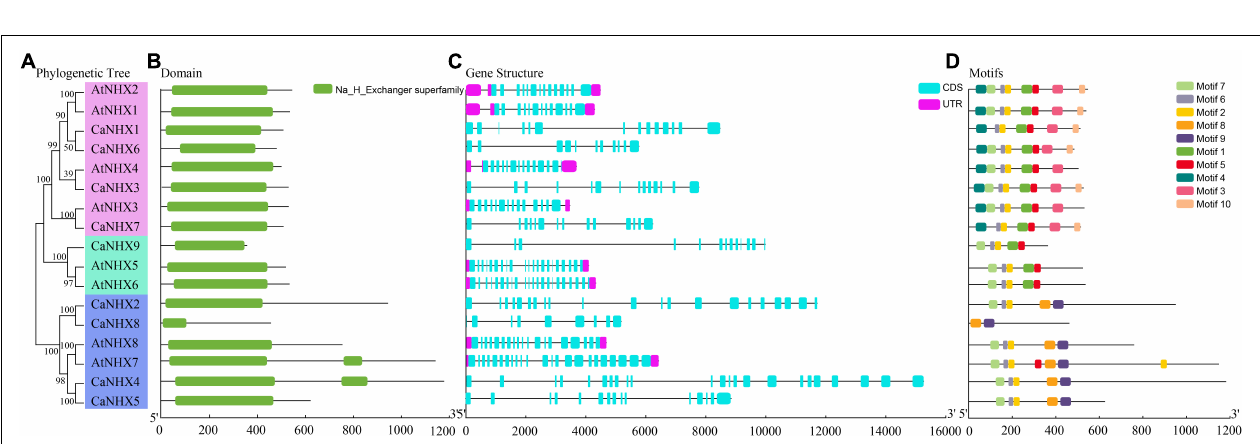
FIGURE 2 | Gene structure and conserved sequence of C. annuum and A. thaliana. (A) Refined relationship between C annuum and A. thaliana . (B) Runctional structure domain. (B) NHX genes. (C) NHX genes structure. (D) Conservative motifs. (D) NHX genes. (E) Motifs.